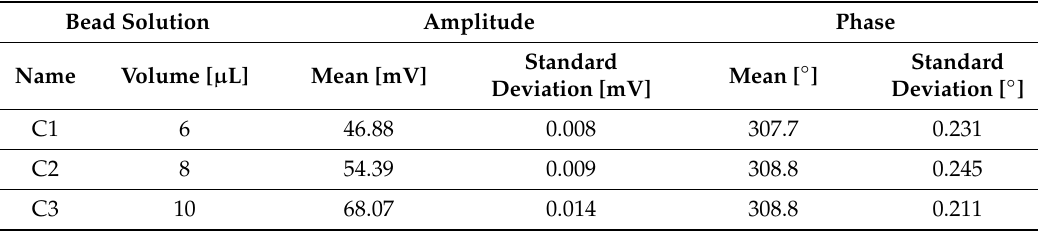
Figure 3. Signal trace while measuring three samples of 1µmSynomagD beads fixed to an immunofiltration matrix. The amount of bead solution used was 6, 8 and 10 µL (always diluted into 400 µL of distilled water), respectively and they were placed in the measurement head in that order. Shown is the signal trace of the amplitude and phase of the component f 1 + 2· f 2 . The areas used for calculating the mean amplitude and phase of the samples (compare Table 1) are highlighted in grey. The excitation frequency ( f 1 ) was kept constant at 40.545 kHz during this experiment. Table 1. Overview of the measured amplitudes and phases for three samples with different concentrations of 1µmSynomagD beads fixed to an immunofiltration matrix. Shown are the results for the component f 1 + 2 · f 2 . The excitation frequency ( f 1 ) was kept constant at 40.545 kHz during this experiment.